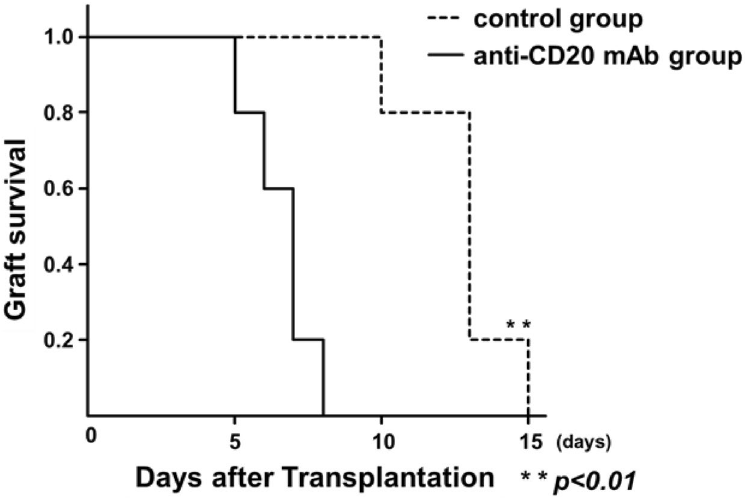
Figure 4. Effect of B cell depletion on allograft survival in sensitized mice. To confirm the anti-donor hyper- responses of CD4 + T cells induced by B cell depletion, the third time allogenic skin transplantation was performed at one week after B cell depletion with anti-CD20 mAb in the sensitized mice (n = 5), and the graft survival period was evaluated. The control group received isotype-matched control antibodies (control group, n = 5). Kaplan–Meier survival curves with log–rank statistics for graft survival are shown. Dotted line, control group; black line, anti-CD20 mAb group; ** p < 0.01.